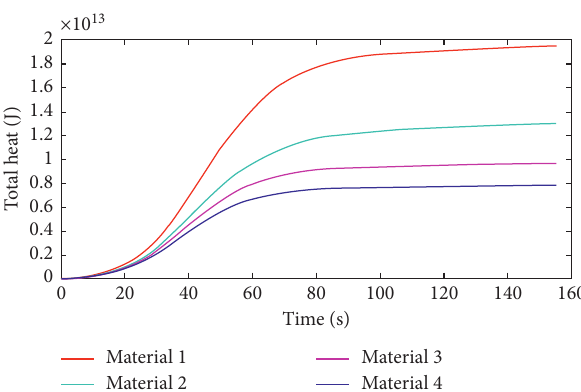
Figure 15: Total heat change curve of four materials with different